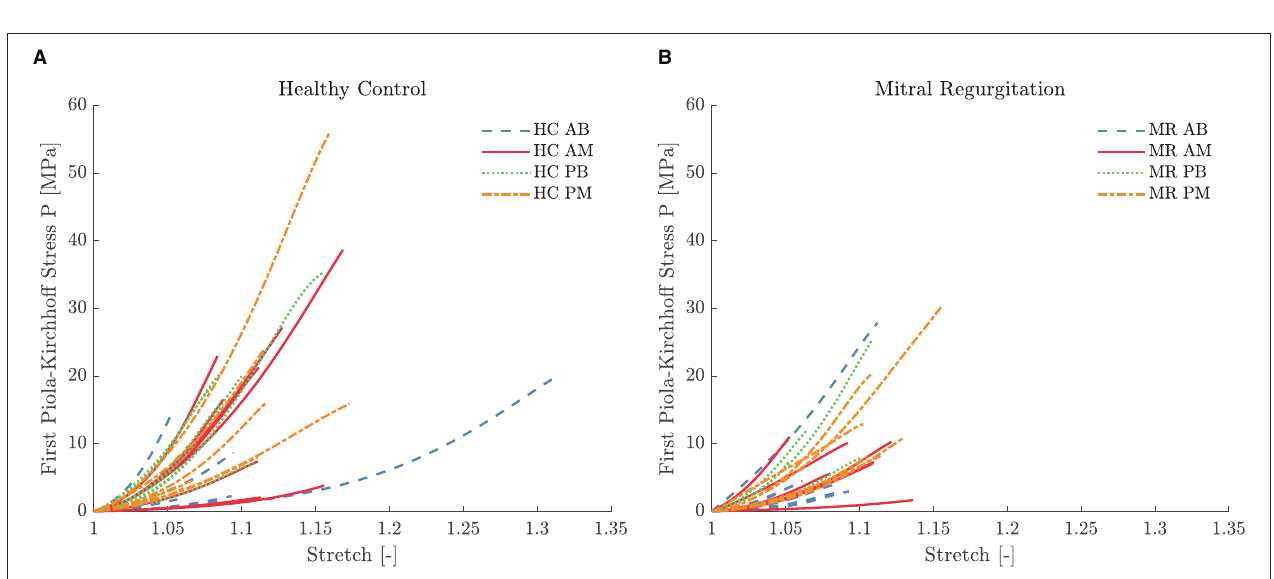
chord mechanics, respectively. Each time, regional